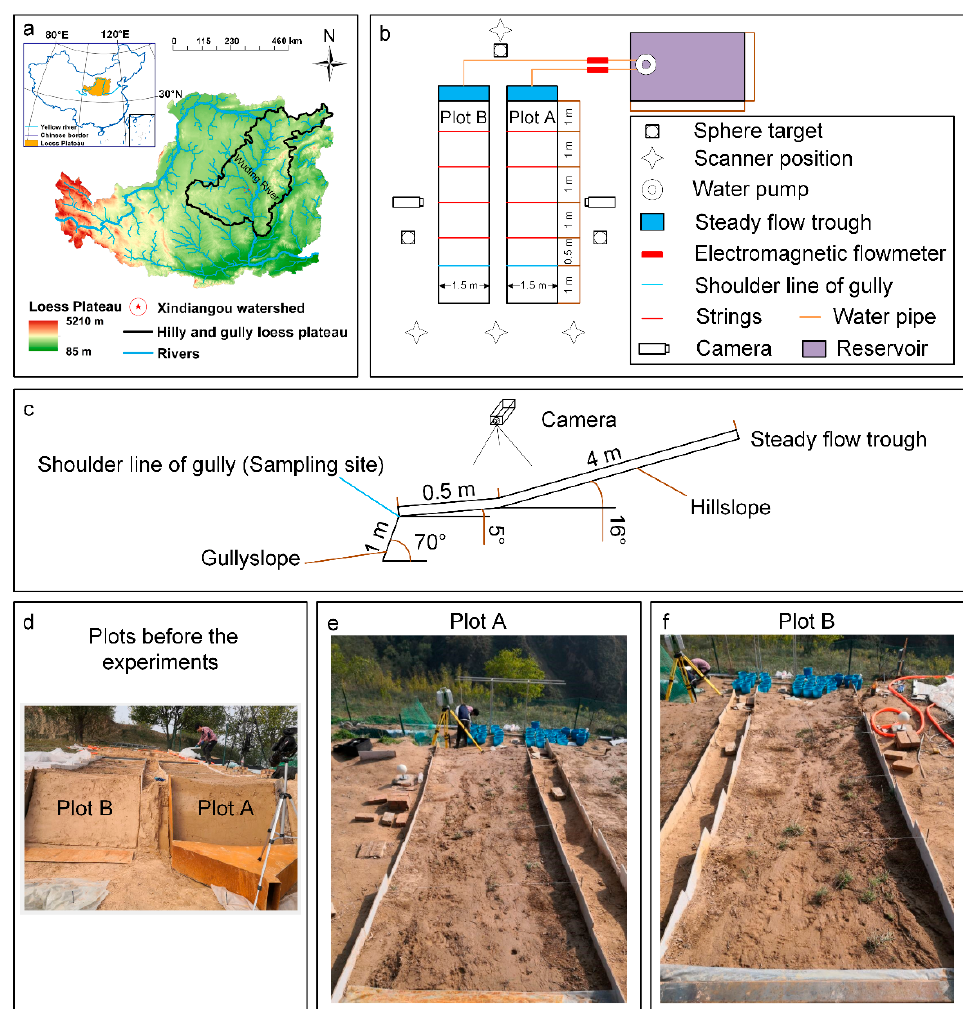
Figure 1. Overview of the study site, including: ( a ) the location of the Xindiangou catchment; ( b ) the layout of experiment design; ( c ) the side view of plots; ( d ) a photo of plots A and B prior to the experiments; ( e ) and ( f ) the photos of plots A and B after all fourteen experiments.